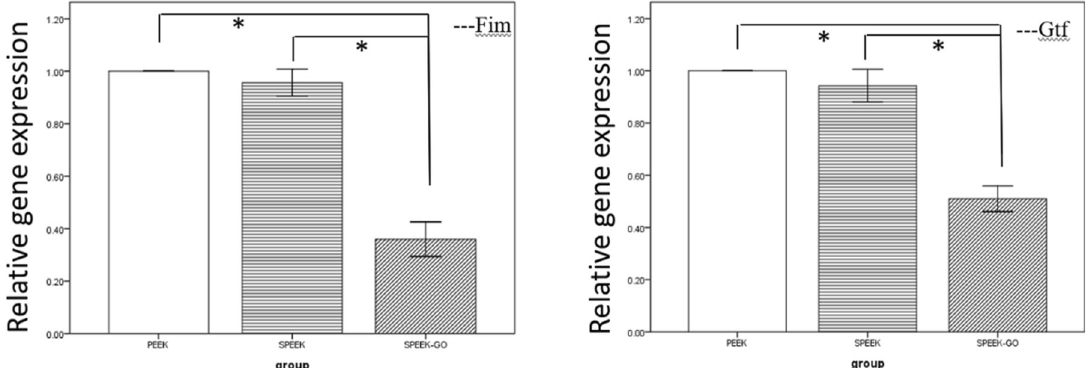
Fig. 11 RT-PCR to evaluate the effects of gene expression. Fim is the pathogenic gene of P. gingivalis and Gtf is the pathogenic gene of S. mutans . The SPEEK-GO group was signi fi cantly different with the other two groups. ( P < 0.01)